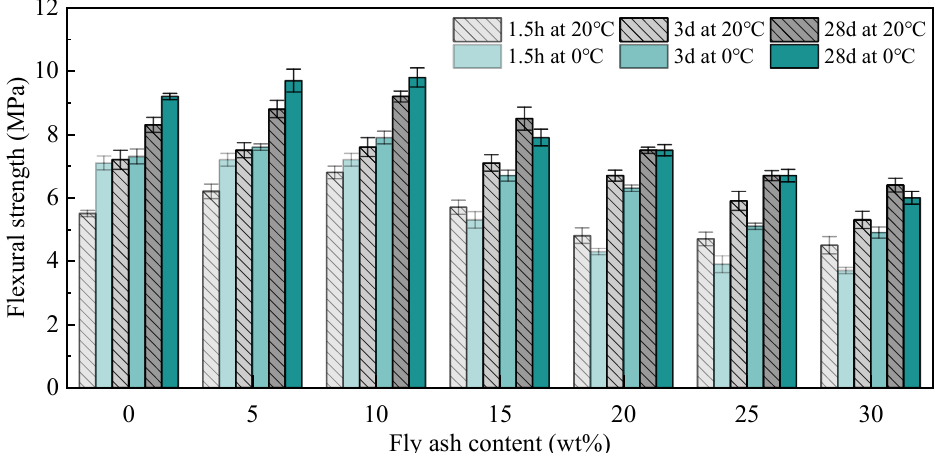
Figure 5. The variation of flexural strength with mixing temperature and fly ash